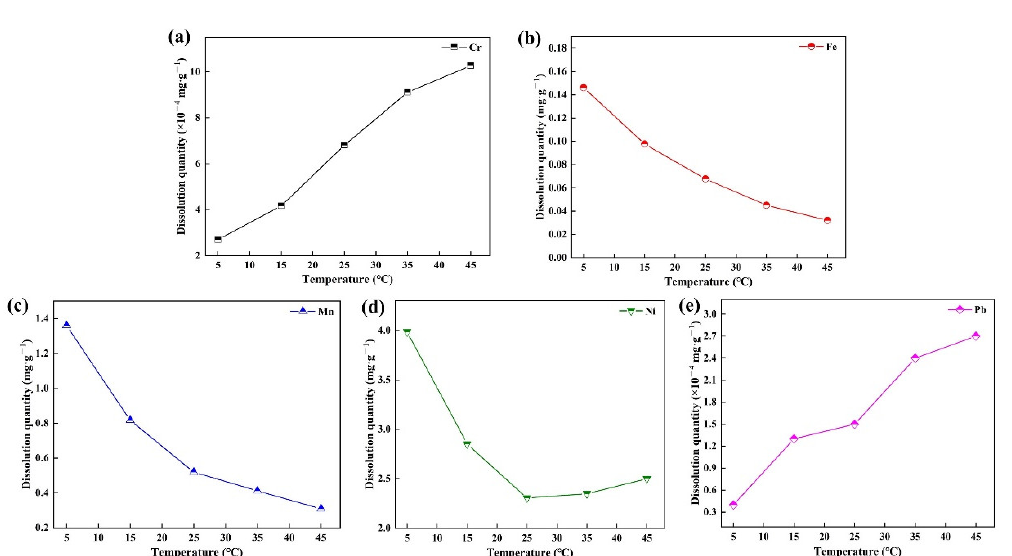
Figure 11. Dissolution effect of metals under different pH conditions . ( a ) is the dissolution curve of Cr; ( b ) is the dissolution curve of Fe; ( c ) is the dissolution curve of Mn; ( d ) is the dissolution curve of Ni; ( e ) is the dissolution curve of Pb.